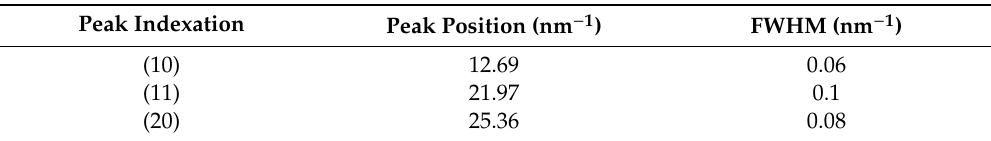
Table 3. Positions and full width at half maximum (FWHM) of the F18OH di ff raction peaks at 15 mN / m obtained by fitting Gaussian